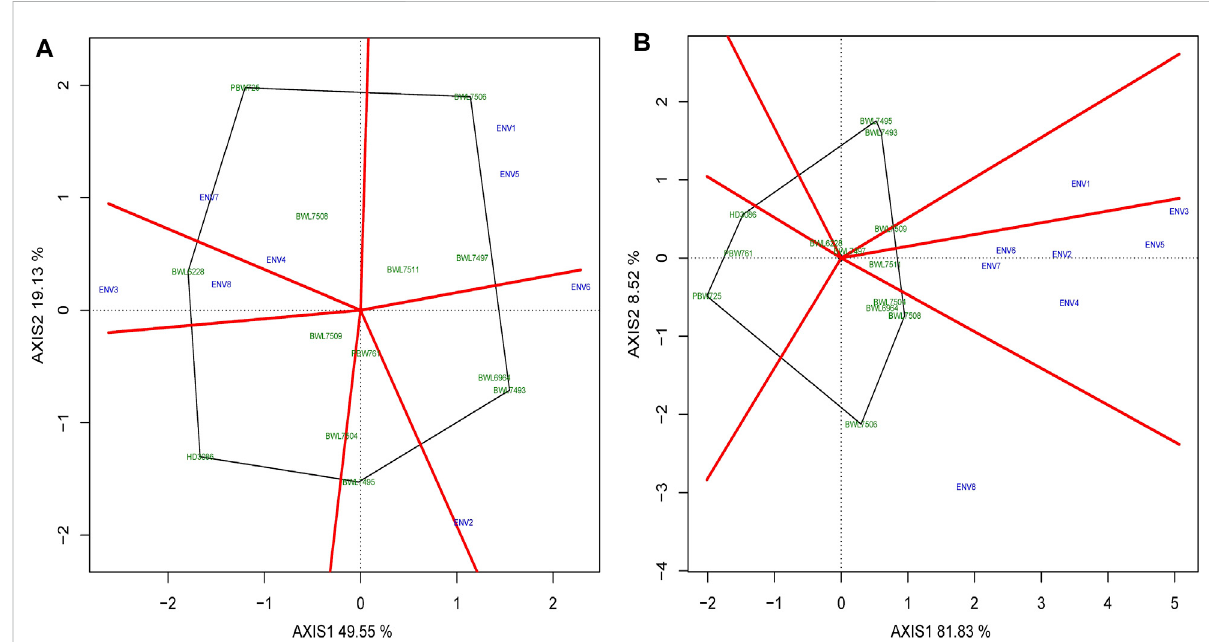
FIGURE 4 The polygon view of “ Which-won-where ” model of GGE biplot representing the performance of 13 bread wheat genotypes and their interactions with environment across four locations (Ludhiana, Ballowal, Patiala, and Bathinda) of Punjab in two consecutive years (2019 – 20, and 2020 – 21)basedon (A) yield(kg/plotand (B) GPC(%).(ENV1,andENV5=Ludhiana;ENV2,andENV6=Ballowal;ENV3,andENV7=Patiala;ENV4,and ENV8 =